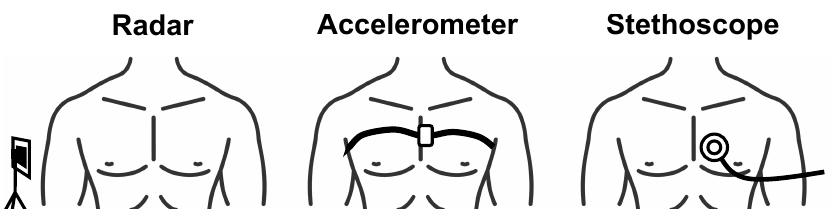
Figure 3. Depiction of contactless radar heart sound measurement compared with conventional heart sound measurement